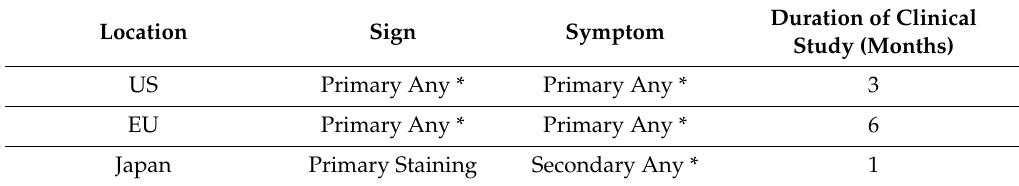
Table 4. Current approval requirements in the US, EU and